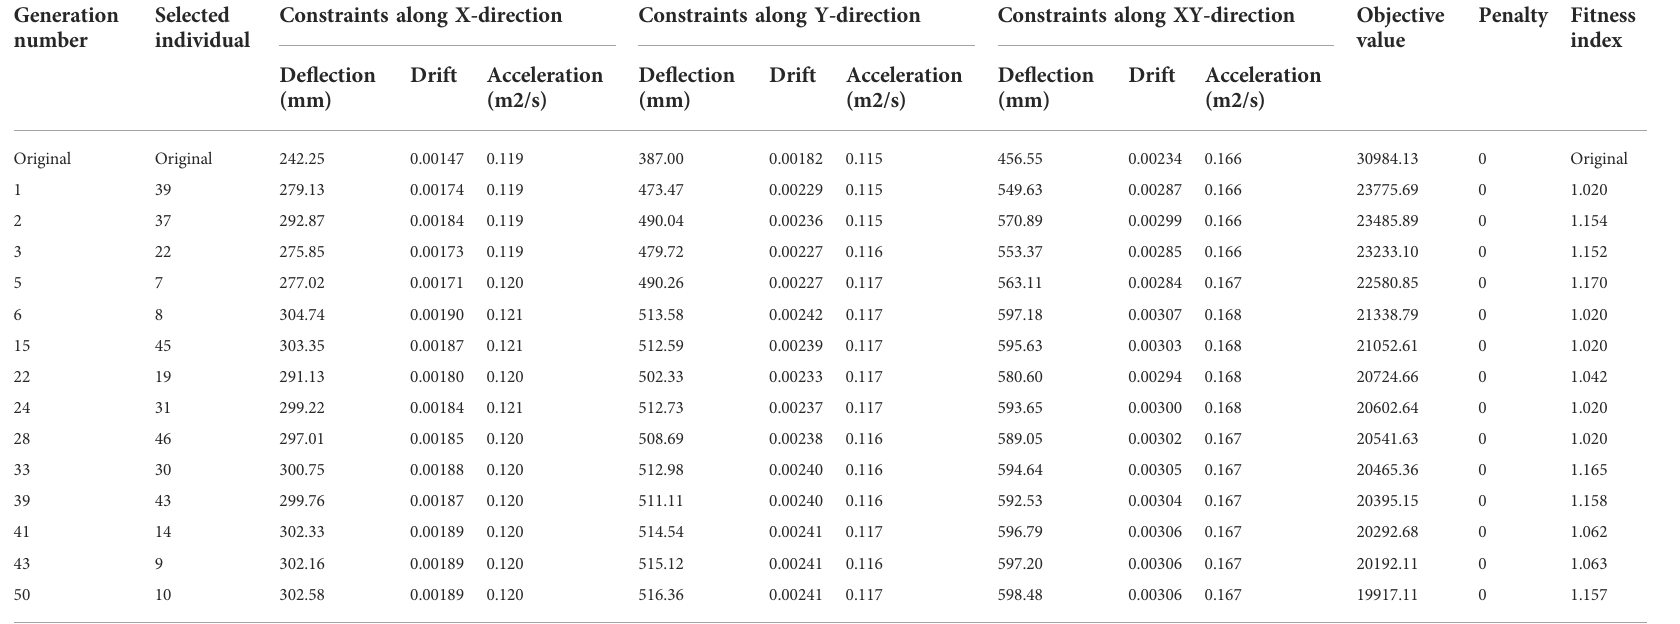
TABLE 2 Genetic Algorithm optimization